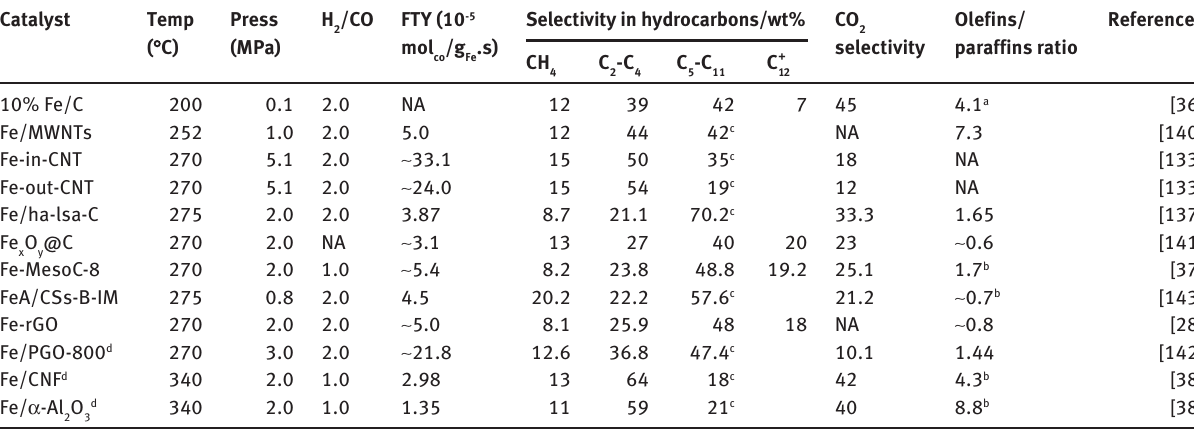
Table 3 Catalytic performance on carbon-supported iron FTS catalysts. Catalyst